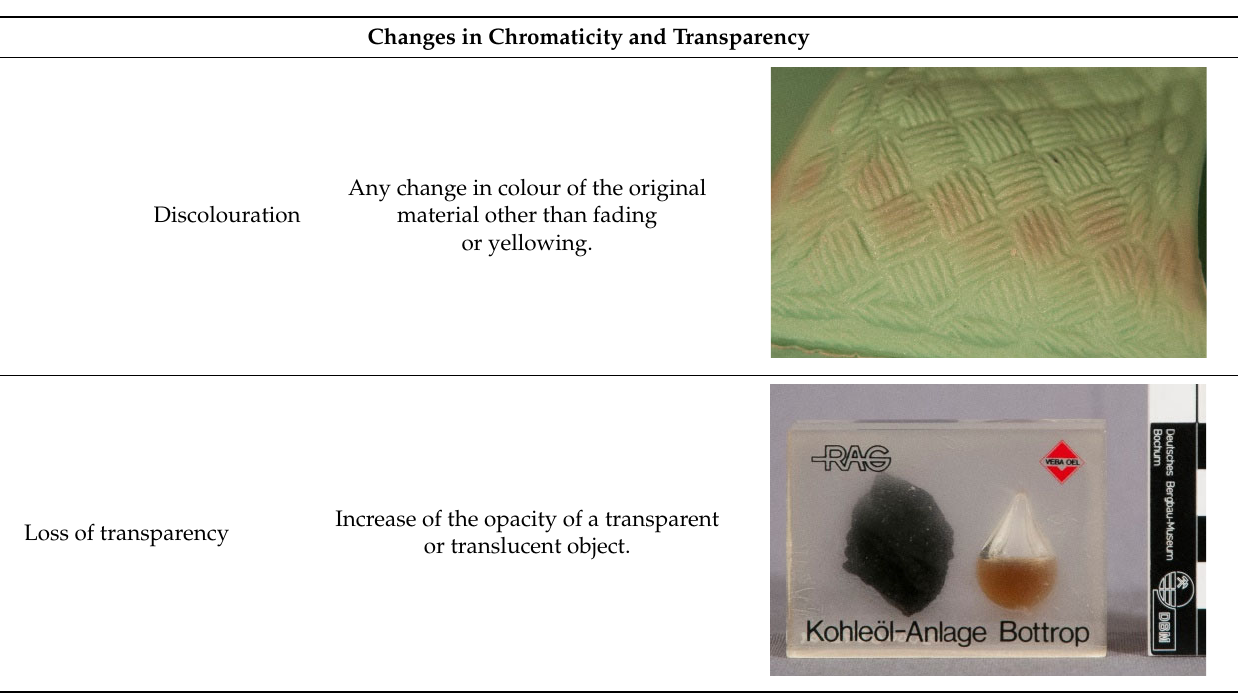
Colour change to a yellow tinge/hue, which can sometimes be Yellowing darker (red/brown). Easily visible in clear or lightly coloured objects. Table 3. Cont. Changes in Chromaticity and Transparency